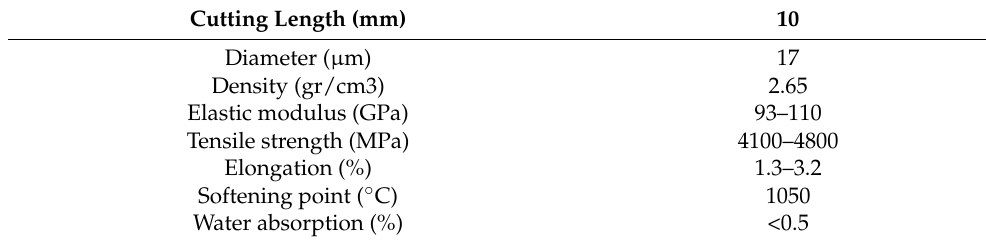
Table 5. Properties of BF used in the